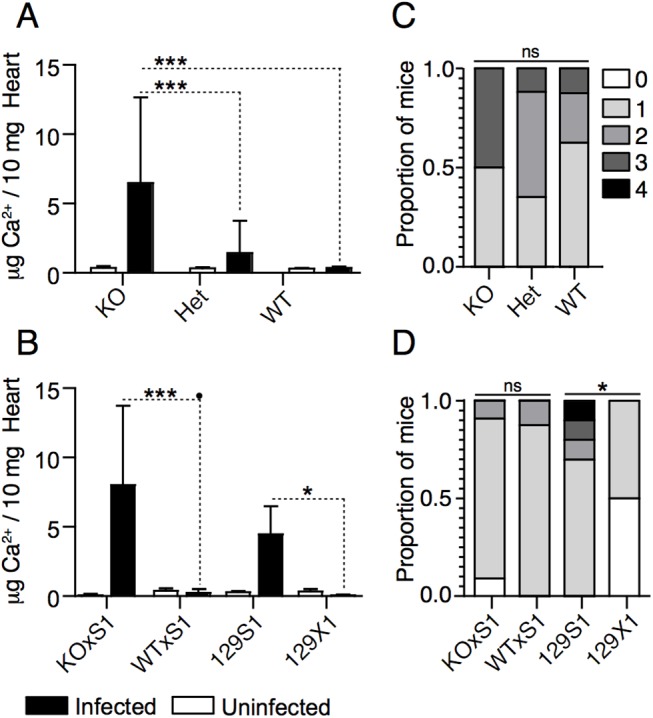
Causative gene identification by allelic complementation tests.Cardiac calcification was quantified in Abcc6 KO, Het, WT, (Abcc6 KO x 129S1)F1, (Abcc6 WTxS1)F1, 129S1, and 129X1 mice before infection and at day 8 post-infection. Abcc6 KO, Het, and WT mice were infected with 50pfu/g CVB3; the rest were infected with 500pfu/g CVB3. The concentration of calcium in uninfected mice was equal between all strains (A, B). At day 8 post-infection, increased calcification was consistently observed only in Abcc6 KO, (Abcc6 KO x 129S1)F1, and 129S1 mice (A,B). The severity of inflammation was evaluated in the same mice. Although differences between 129S1 and 129X1 were apparent, inflammation severity did not differ significantly between the other groups (C, D). The statistical test for panels A and B was a two-way ANOVA followed by Bonferonni post tests. The statistical test for panels C and D was a one-way ANOVA followed by a Dunn’s post-test. *: P<0.05, ***: P<0.001, ns: not significant.